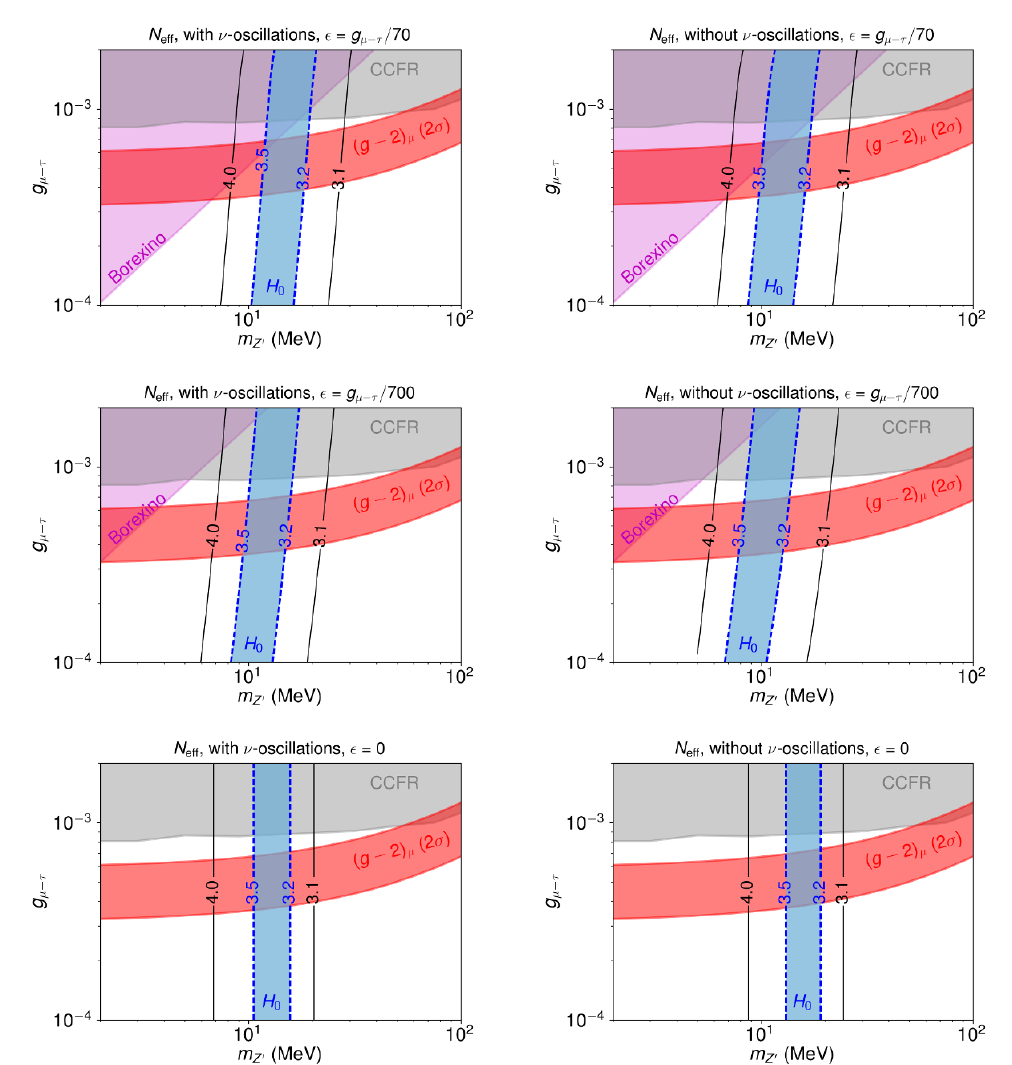
Figure 5 . Contours of constant N e(cid:11) as a function of the Z 0 mass and gauge coupling for three di(cid:11)er- ent values of the kinetic mixing parameter, (cid:15) . In the left panels we assume that neutrino oscillations equilibrate the (cid:23) e component such that T (cid:23) = T (cid:23) , whereas neutrino oscillations are neglected in e (cid:22) the right frames. We also show are the regions of parameter space favored by measurements of the muon’s anomalous magnetic moment, ( g (cid:0) 2) (cid:22) , as well as those excluded by measurements of di-muon production in neutrino nucleus scattering (CCFR) [5, 40], and solar neutrino scattering (Borexino) [24, 41, 42] (see section 4). This parameter space is also constrained rare kaon decays, but the bound is weaker than the CCFR region above [52]. Intriguingly, the full parameter space that simultaneously ameliorates both the H 0 and ( g (cid:0) 2) (cid:22) anomalies can also be tested with (cid:12)xed target experiments [53{56], rare kaon decays [52, 57], and at Belle-II [58, 59].